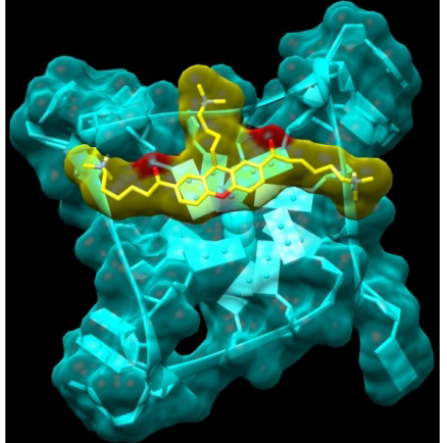
Figure 5. Model obtained for the complex between the XA3c (14), yellow atom-type) and the monomeric G-quadruplex (light